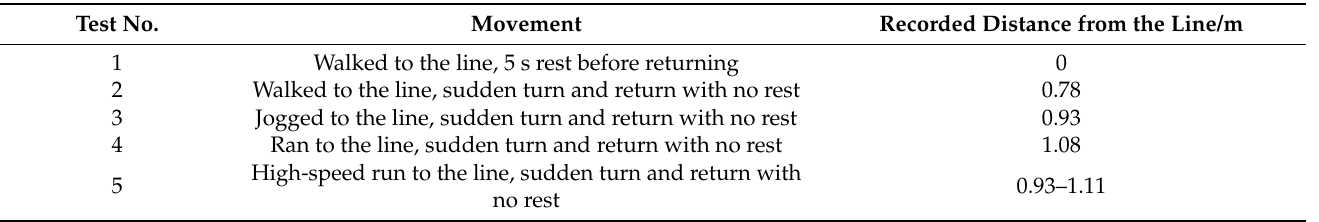
Table 1. Recorded position of turn point for a test person moving to a defined line and then return ‐ ing.